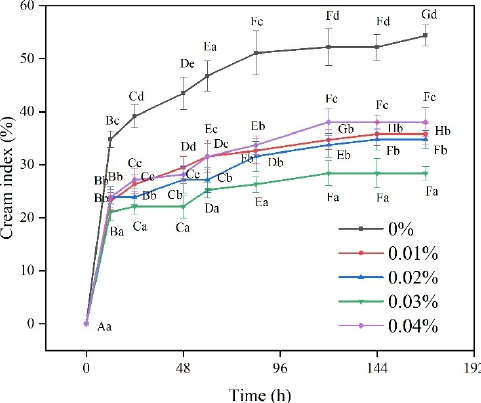
Figure 5. Cream index of wooden breast myofibrillar protein emulsions with different (-)-epigallocatechin-3-gallate contents. Means with different letters (a–e, A–G) within the same parameter group differ significantly ( p < 0.05).